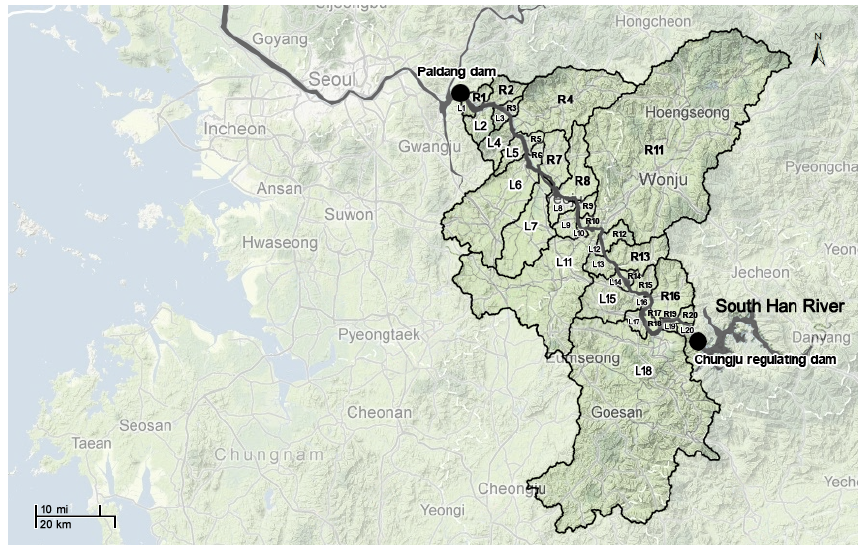
Figure 3. Study area and watershed